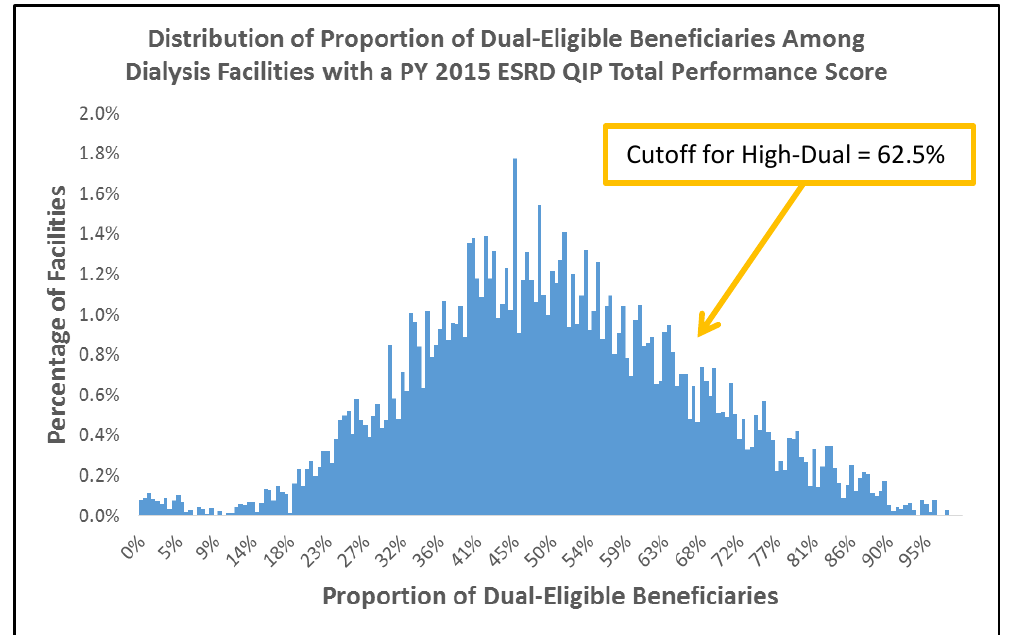
Figure 11.1: Distribution of dually-enrolled beneficiaries across dialysis